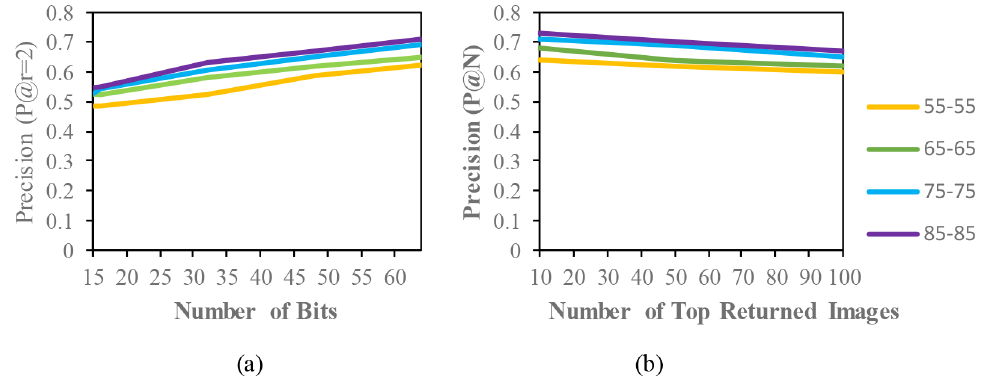
Figure 6. Comparison of the (a) precision curves at a Hamming radius of 2 (P@r = 2) with different bit lengths and the (b) precision curves of the top-N returned images on the different